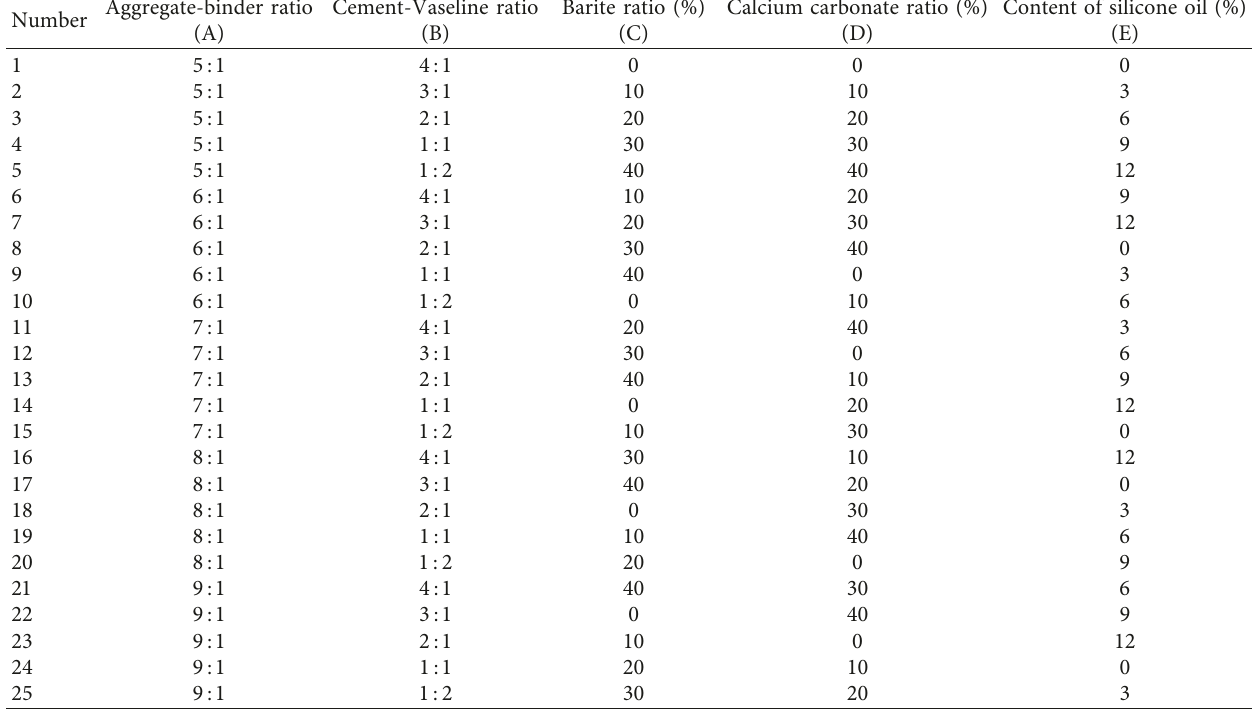
Table 1: Orthogonal test scheme.